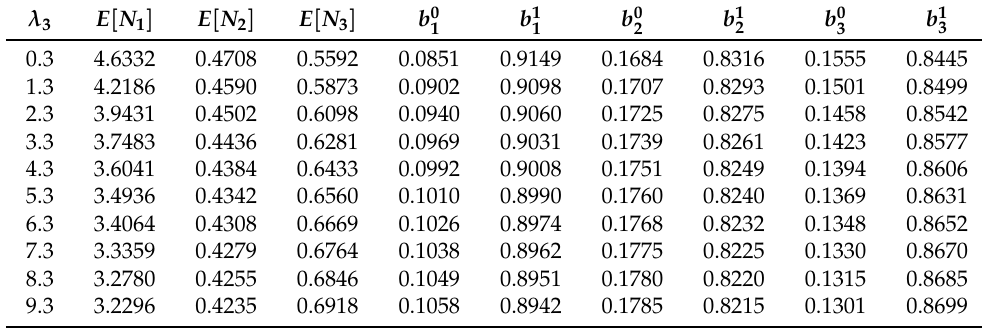
Table 12. Effect of λ 3 on various performance